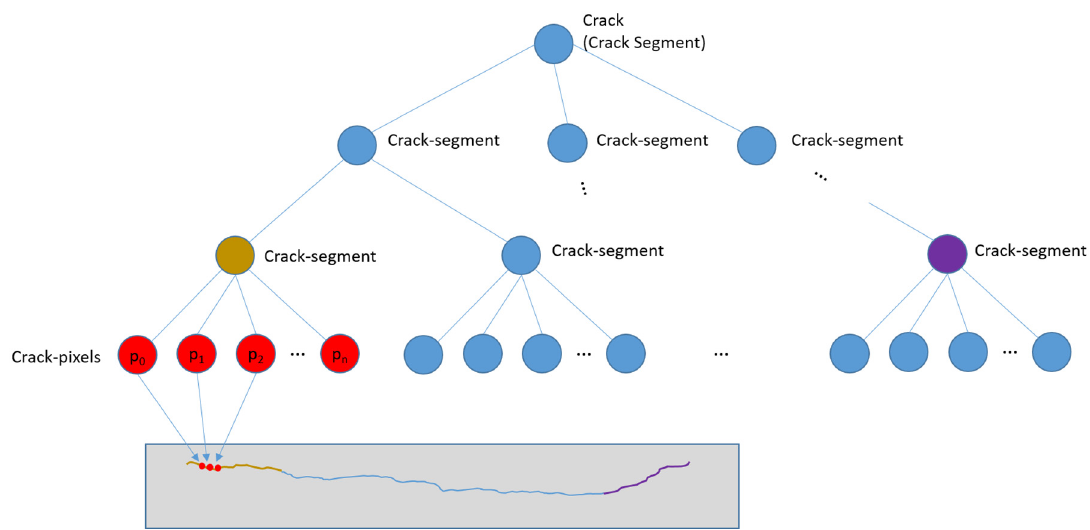
Figure 7. Hierarchy of crack pixels and crack segments.